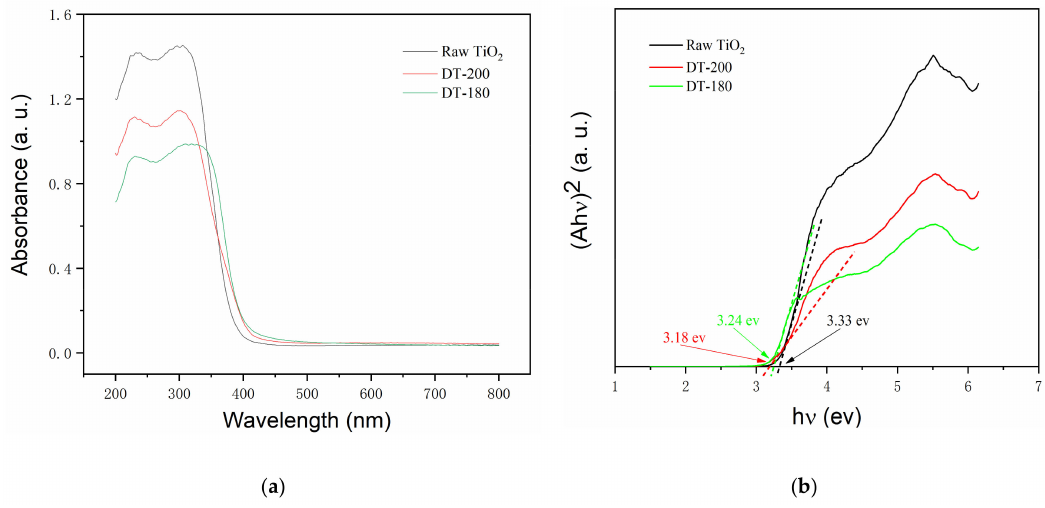
Figure 5. ( a ) Ultraviolet–visible (UV-vis) absorption spectra; ( b ) Tauc plots of samples to show band gap